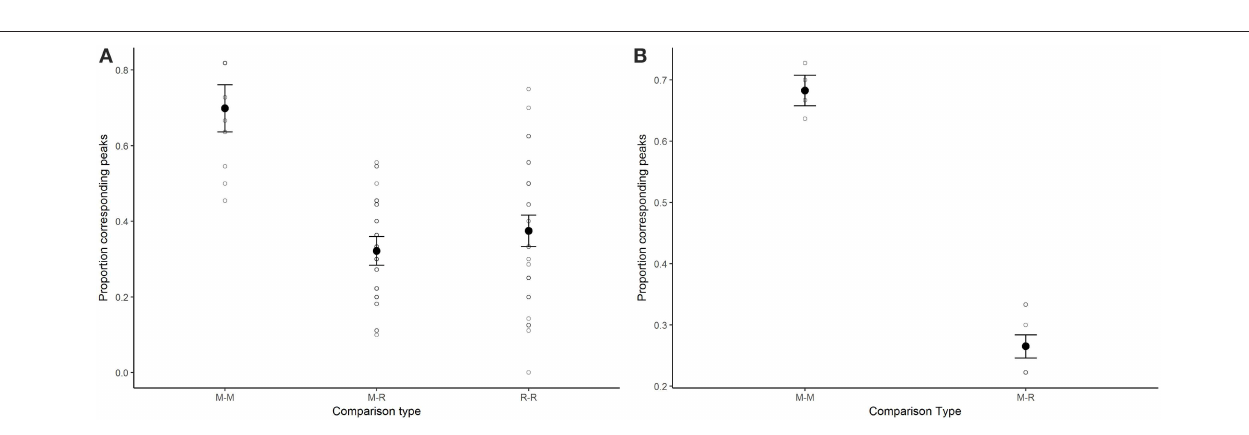
FIGURE 4 | Model derived estimates and associated standard errors of the proportion of corresponding peaks among species-species annual population indices for models that tested for a difference among groups, for (A) a model that looked at all species-species comparisons across the 14 migrant (M) and resident (R) species (M-M: n = 10; M-R, n = 45; R-R, n = 36), and (B) a model that included only species-species comparisons that included the monarch butterfly (M-M, n = 4; M-R, n = 7). In both cases, the proportion of corresponding peaks for each species-species comparison is also plotted for each group (open